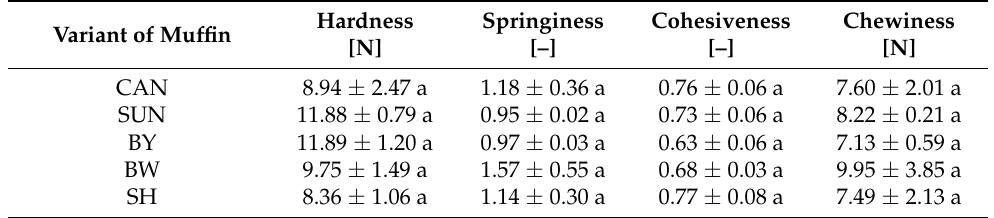
Table 4. Hardness, springiness, cohesiveness, and chewiness of gluten-free muffins. Variant of